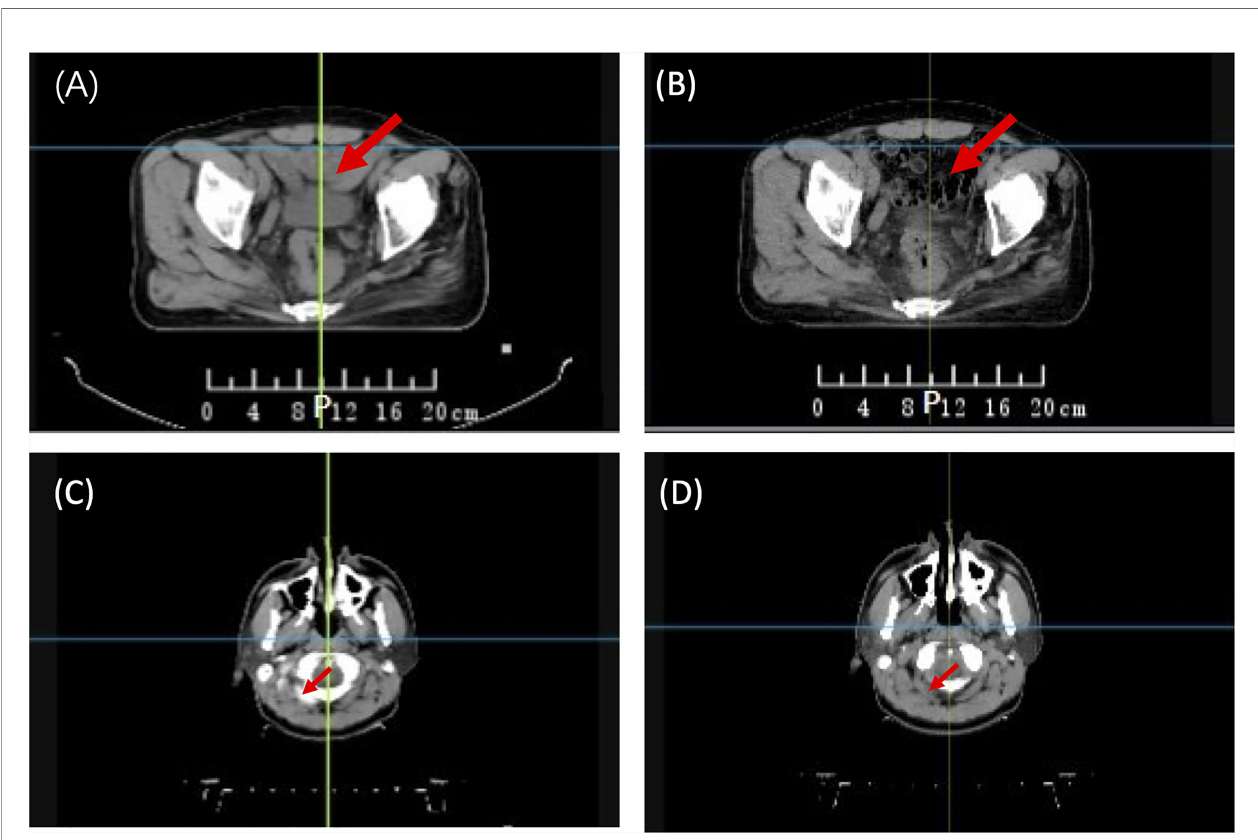
FIGURE 1 | Anatomical variations between planning CT (pCT) and daily CT (dCT). (A) pCT of a rectal patient; (B) dCT of a rectal patient; (C) pCT of an NPC patient; and (D) dCT of an NPC patient. NPC, Nasopharyngeal